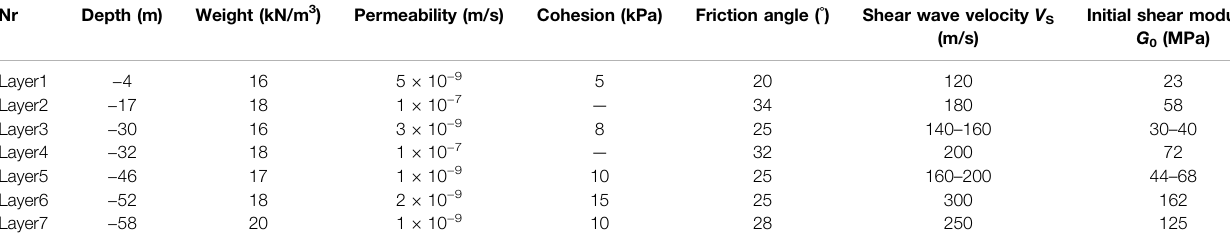
TABLE 1 | Material properties determined based on CPTU interpretation